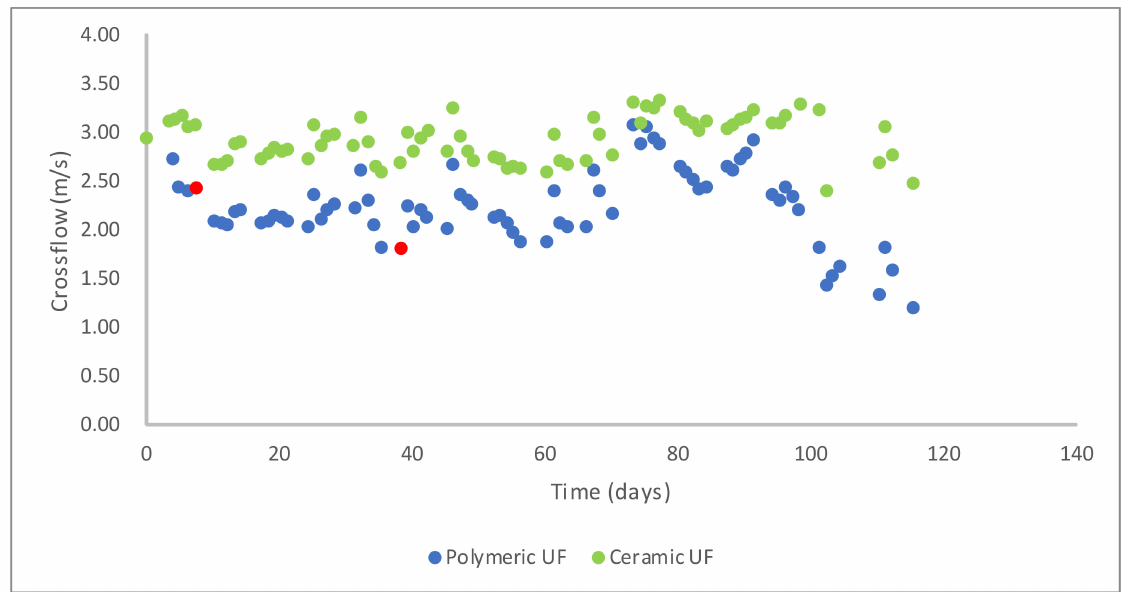
Figure 1. Crossflow achieved in each UF line at similar recirculation flow. The red dots indicate the membrane changeovers on the polymeric UF